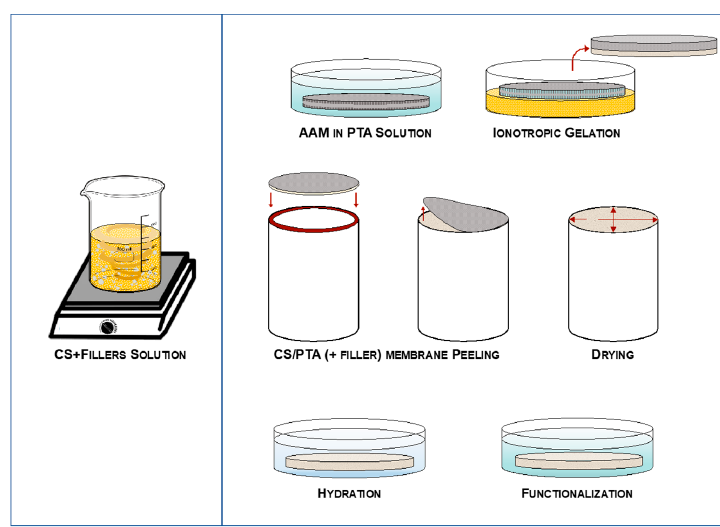
Figure 1. Ionotropic gelation process of the hybrid CS/PTA + filler membranes.